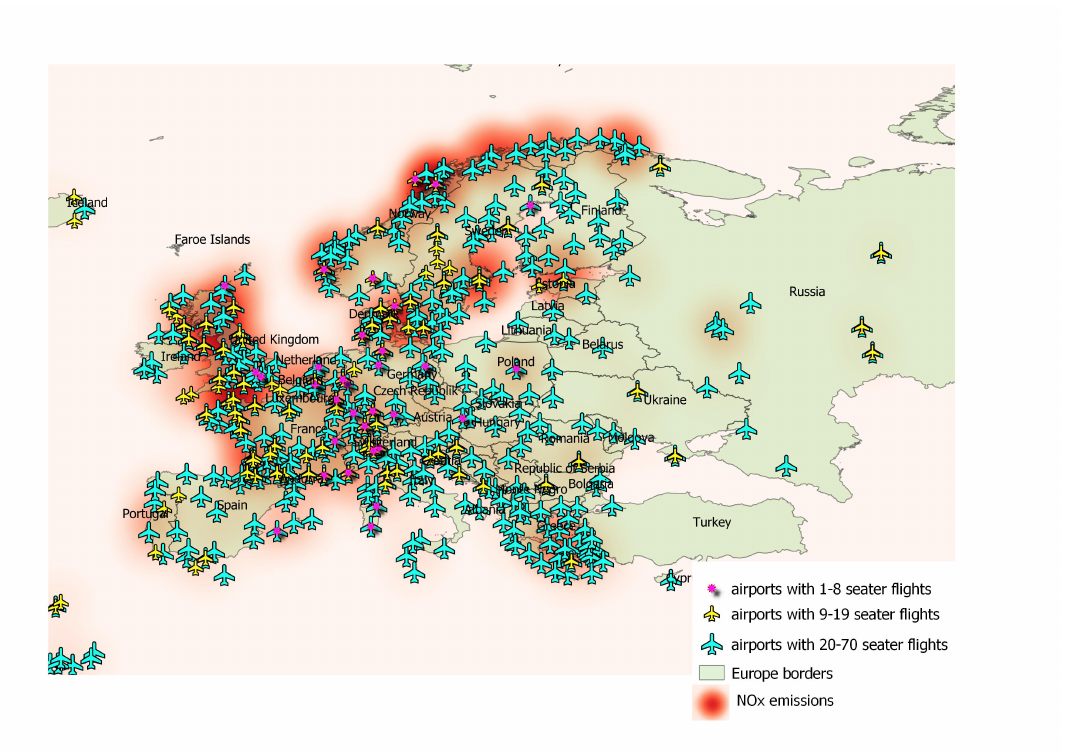
Figure 7. Geographical distribution of NO x gas emissions due to regional aircraft in the EU. The distributions of HC and CO gas emissions are almost identical and are, therefore, not shown as separate